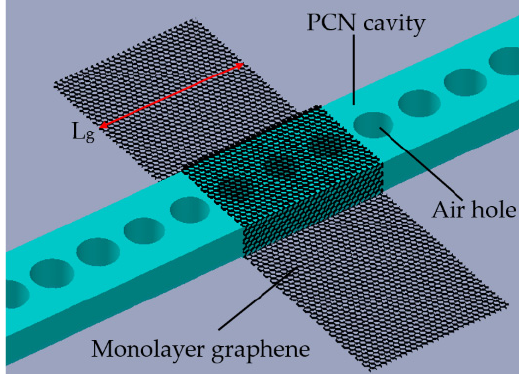
Figure 28. Proposal scheme of opto-mechanical PCN cavity with graphene integrated.